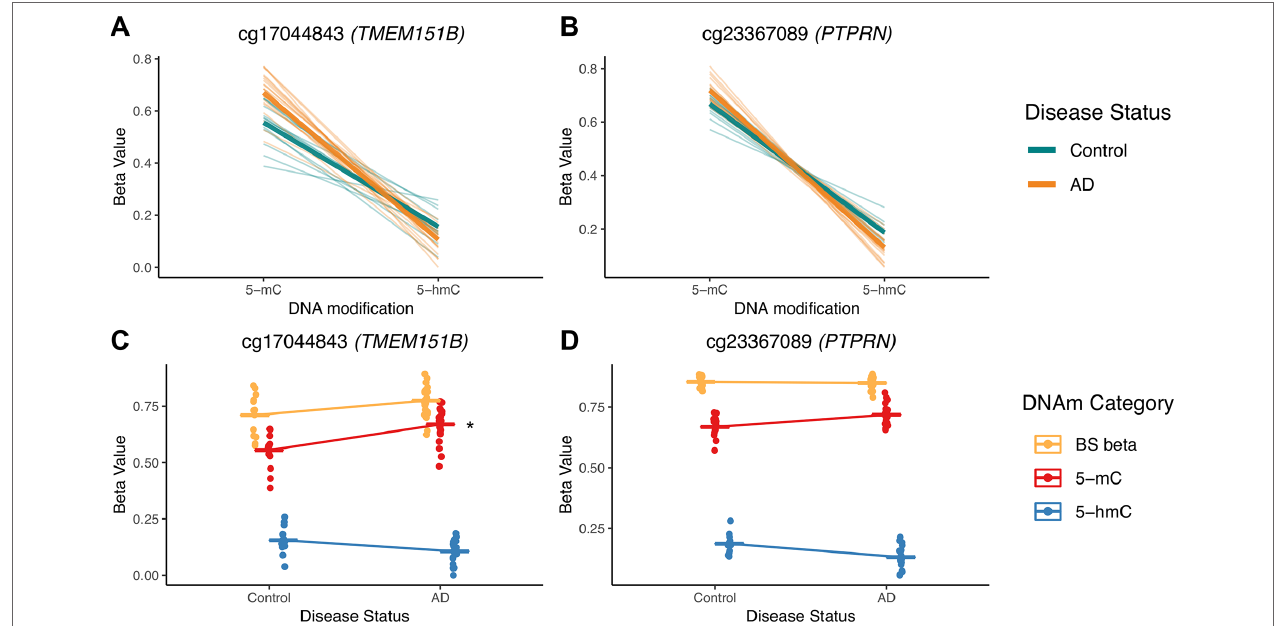
FIGURE 7 | 5-mC and 5-hmC levels at two example DIPs. To illustrate the value of our statistical approach, we visualized two DIPs at probes in the TMEM151B (cg17044843) and PTPRN (cg23367089) genes. Beta values for these two probes are represented in two ways—with either DNA modification category (A , B) or disease status (C , D) on the x-axis. Beta values are presented for raw BS converted DNA (BS beta), as well as 5-mC and 5-hmC, as calculated using maximum likelihood estimation. These two probes were selected to represent two scenarios in which traditional modeling misses information about 5-mC and/or 5-hmC, as previously outlined in Figure 3 . At the cg17044843 probe, we found a significant negative interaction between DNA modification category and disease status (A) , but only 5-mC levels were identified as significant in traditional modeling (C) . Meanwhile, at the cg23367089 probe, we found a significant negative interaction between DNA modification category and disease status (B) , but neither 5-mC nor 5-hmC were significantly changed with AD in the traditional modeling approach (D) . At both of these sites, traditional modeling failed to capture subtle changes in 5-mC and/or 5-hmC levels with AD. In A and B, thin lines represent a slope between 5-mC and 5-hmC within individuals, and thicker lines represent smoothed means for the two disease status groups. In B and C, dots represent individuals, and lines represent magnitude and direction of changes between disease groups, not slope within individuals. The asterisk indicates a significant effect of AD on mean DNA modification beta value in traditional, separate